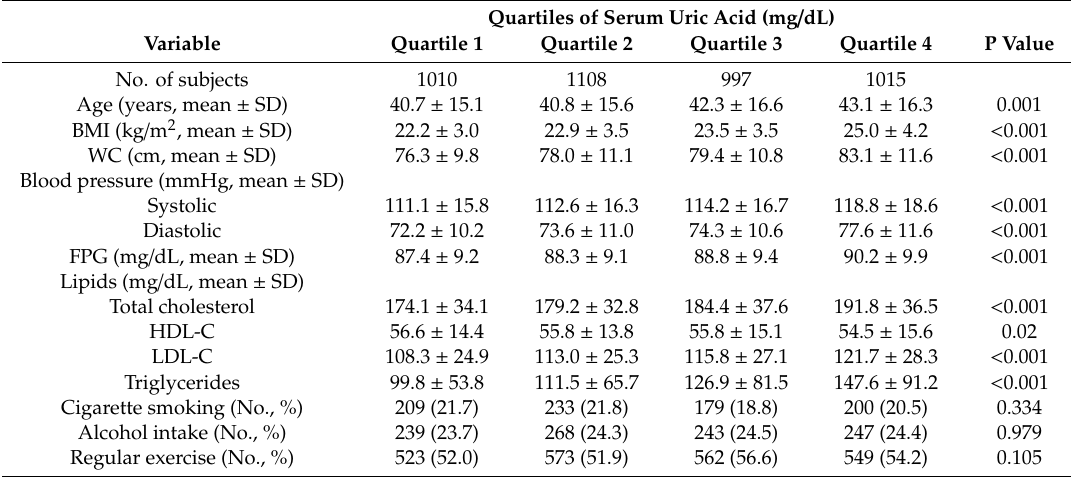
Table 1. Baseline characteristics of the study population by quartiles of serum uric acid.